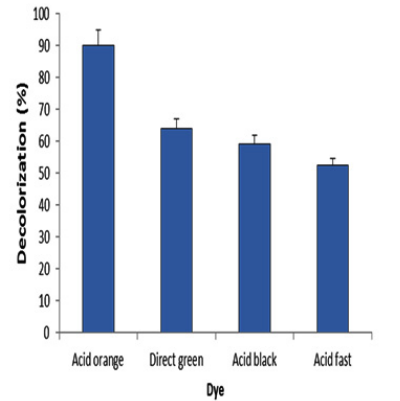
Fig. 11. Decolorization efficiency of different Azo dyes by silver nanoparticles